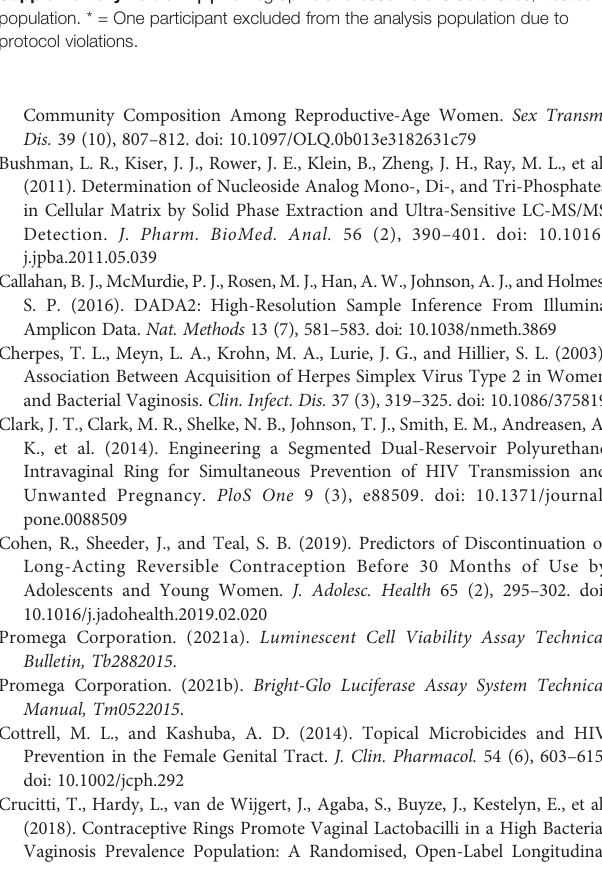
Supplementary Table 2 | | Demographic and baseline characteristics, treated population. * = One participant excluded from the analysis population due to protocol